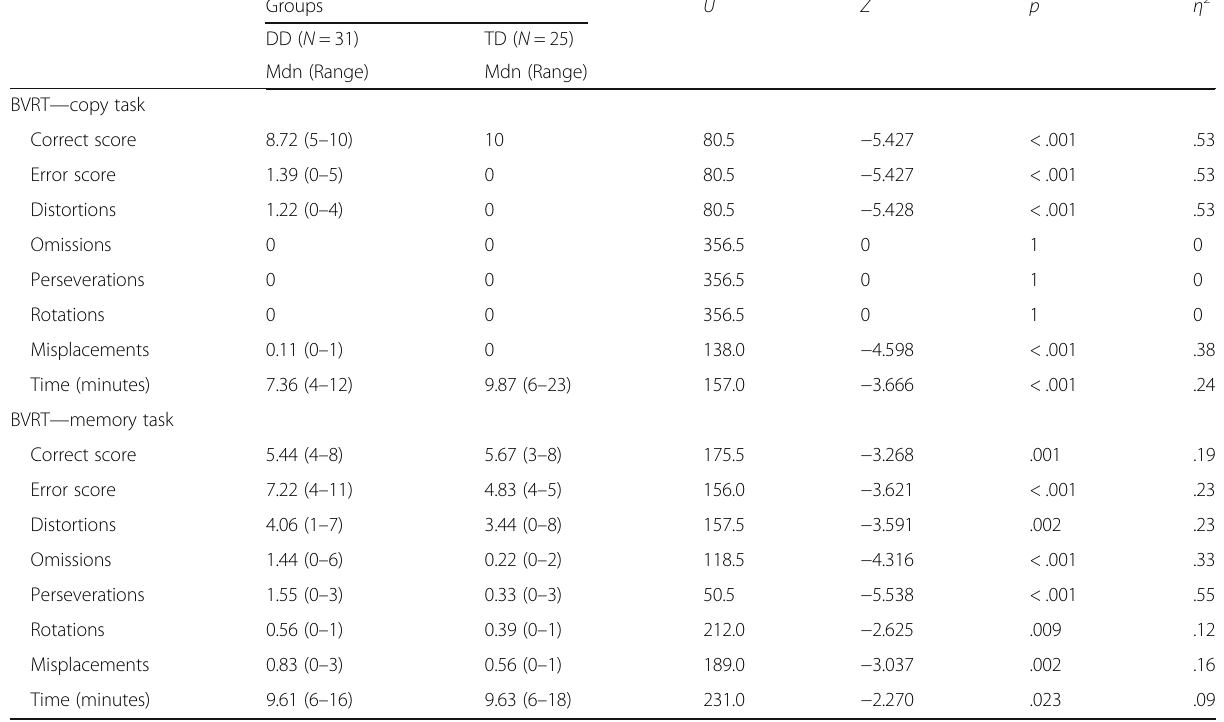
Table 2 BVRT performance by groups (Mann-Whitney